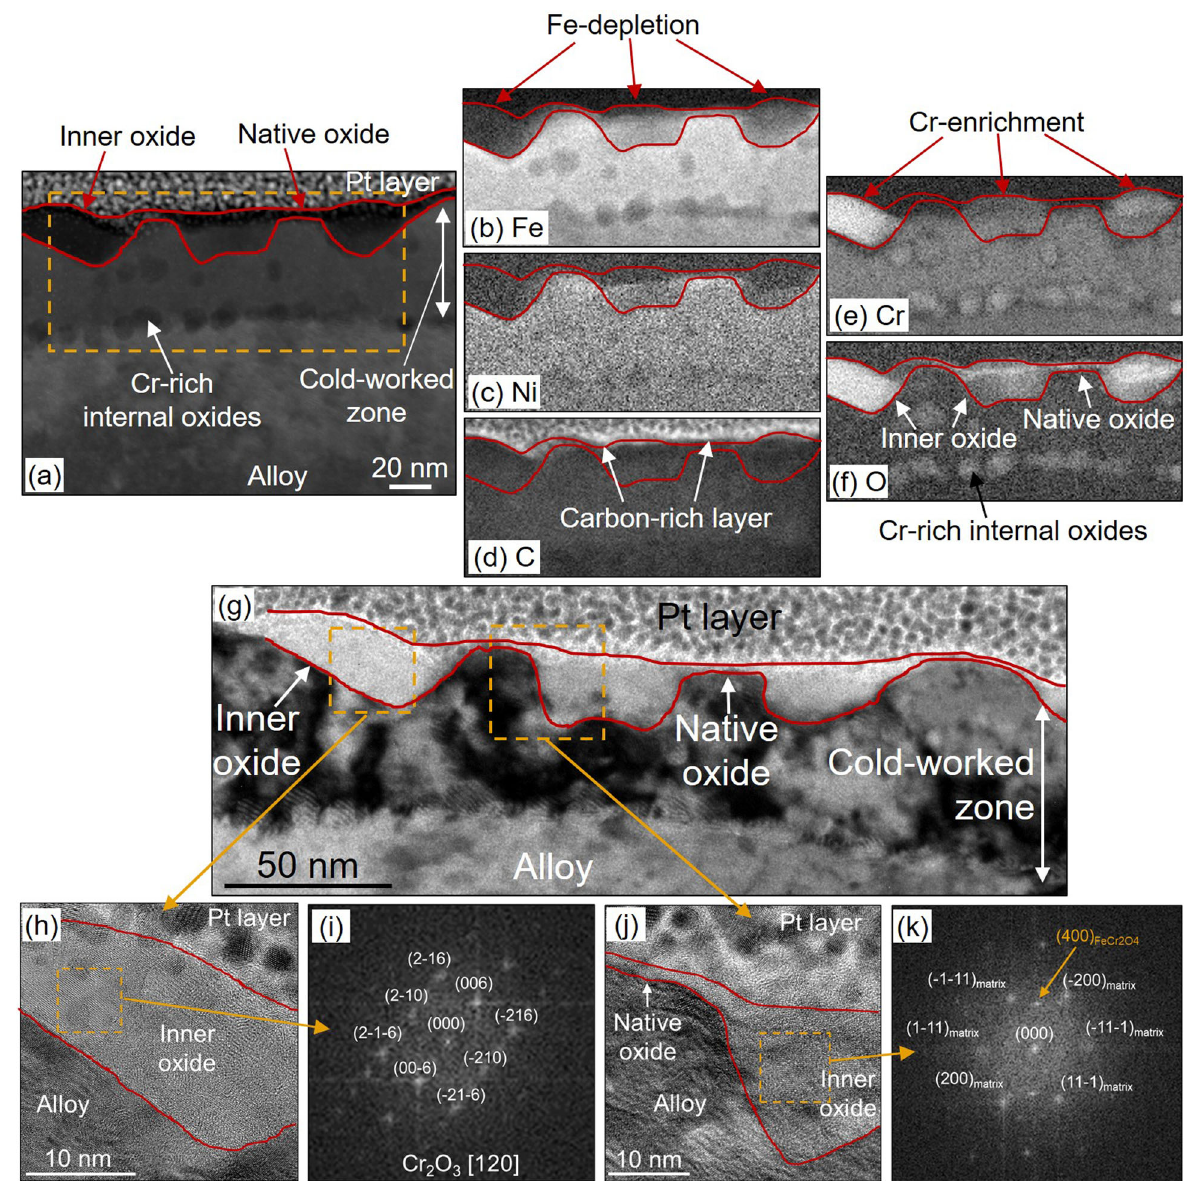
Fig. 7 Cross-sectional TEM analysis of Fe22Ni22Cr after AP-XPS in high purity CO 2 . a STEM reference image. b – f EELS mapping of the area indicated by the orange dashed line in a . g Bright- fi eld TEM image of the same region used for EELS mapping. h , j HRTEM images of the regions indicated by orange dashed lines in g . i , k FFT patterns of the regions indicated by orange dashed lines in h and j . The oxide layer is delineated by the red